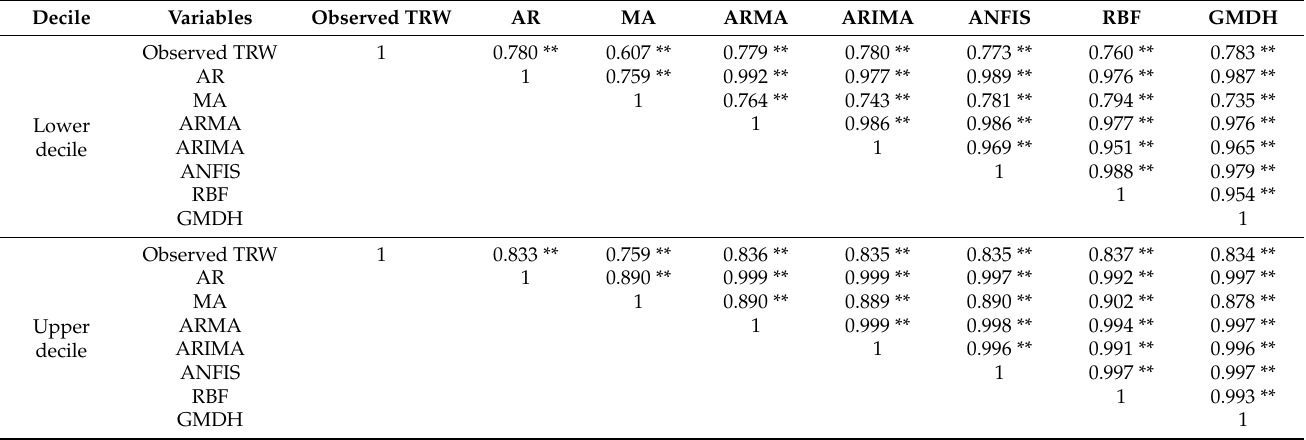
Table 3. Spearman non-parametric correlation test between the outputs and observations in the upper and lower TRW deciles.